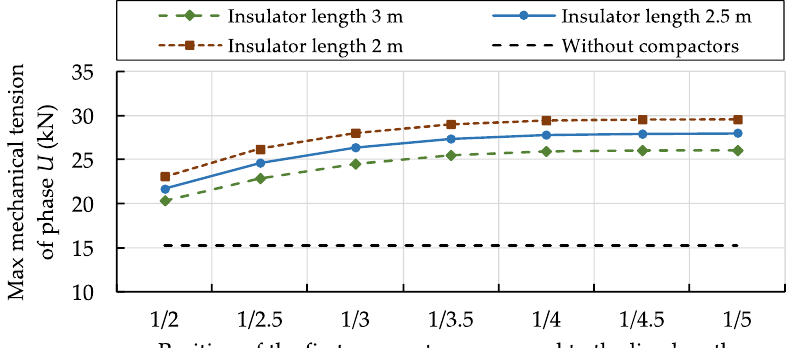
Figure 12. Influence of the external compactors position on the maximum mechanical tension of the most stressed phase conductor (phase U ), for different lengths of rod insulators composing the compactors (the dotted black line refers to the case without compactors).